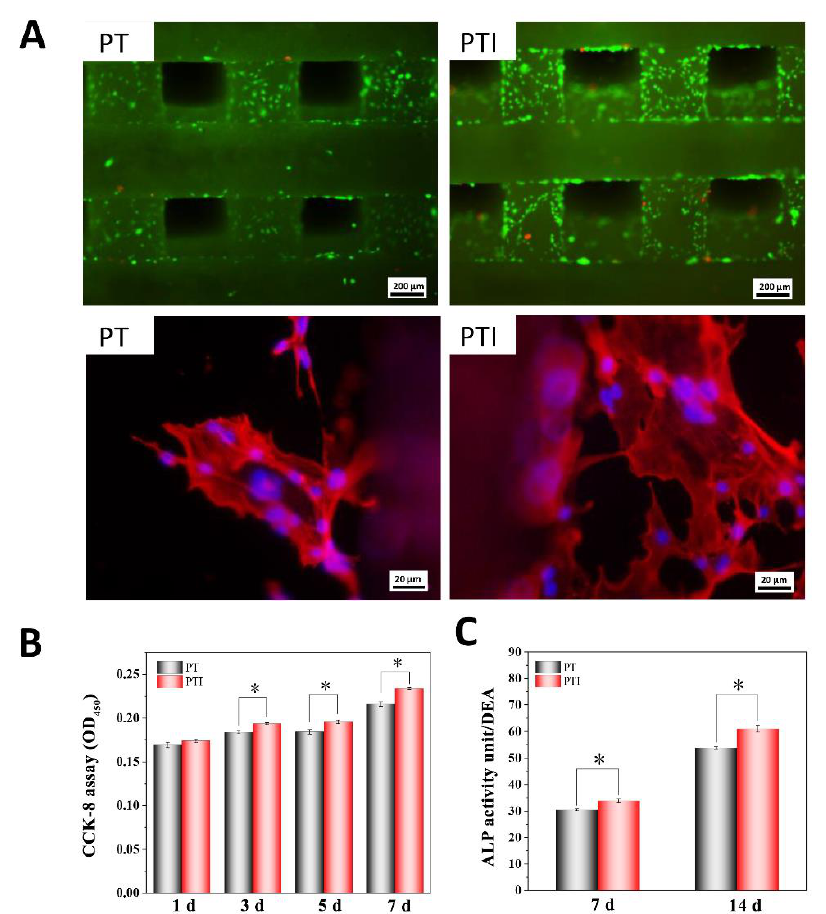
Figure 4. Cytocompatibility and osteogenic differentiation. ( A ) Living(green)/dead(red) cell and cytoskeleton/nucleus stain, ( B ) cell proliferation ability, and ( C ) ALP activity assay ( n = 3, * p < 0.05).